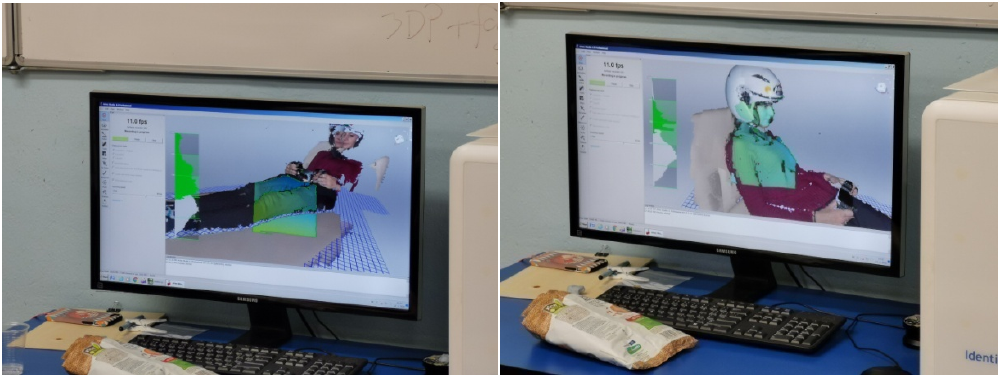
Figure 3. Use of the Artec Evascanner.